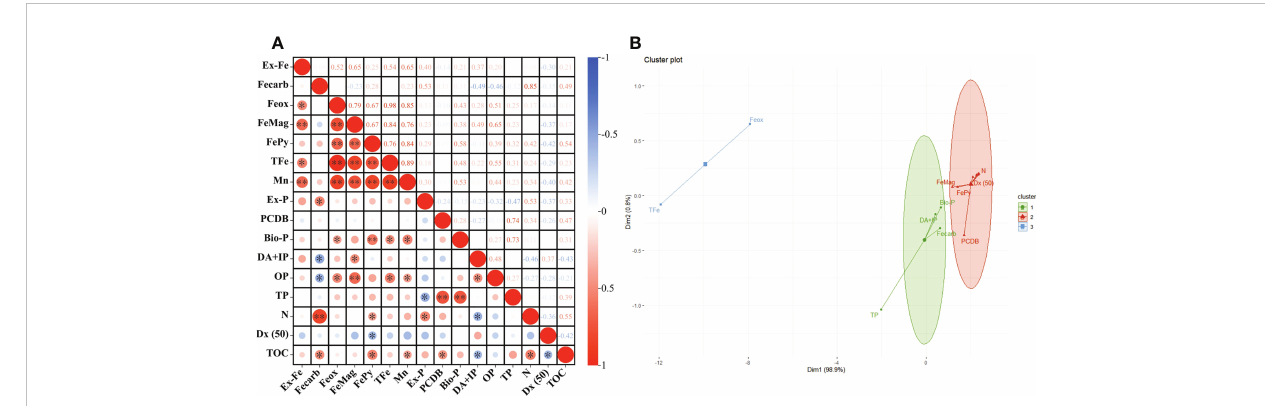
FIGURE 6 Correlation between TOC and different parameters of sediments. “ * ” and “ ** ” indicated signi fi cant correlations at P < 0.05 level and P <0.01 level respectively (A) . K-means clustering analysis results of different parameters (B) .